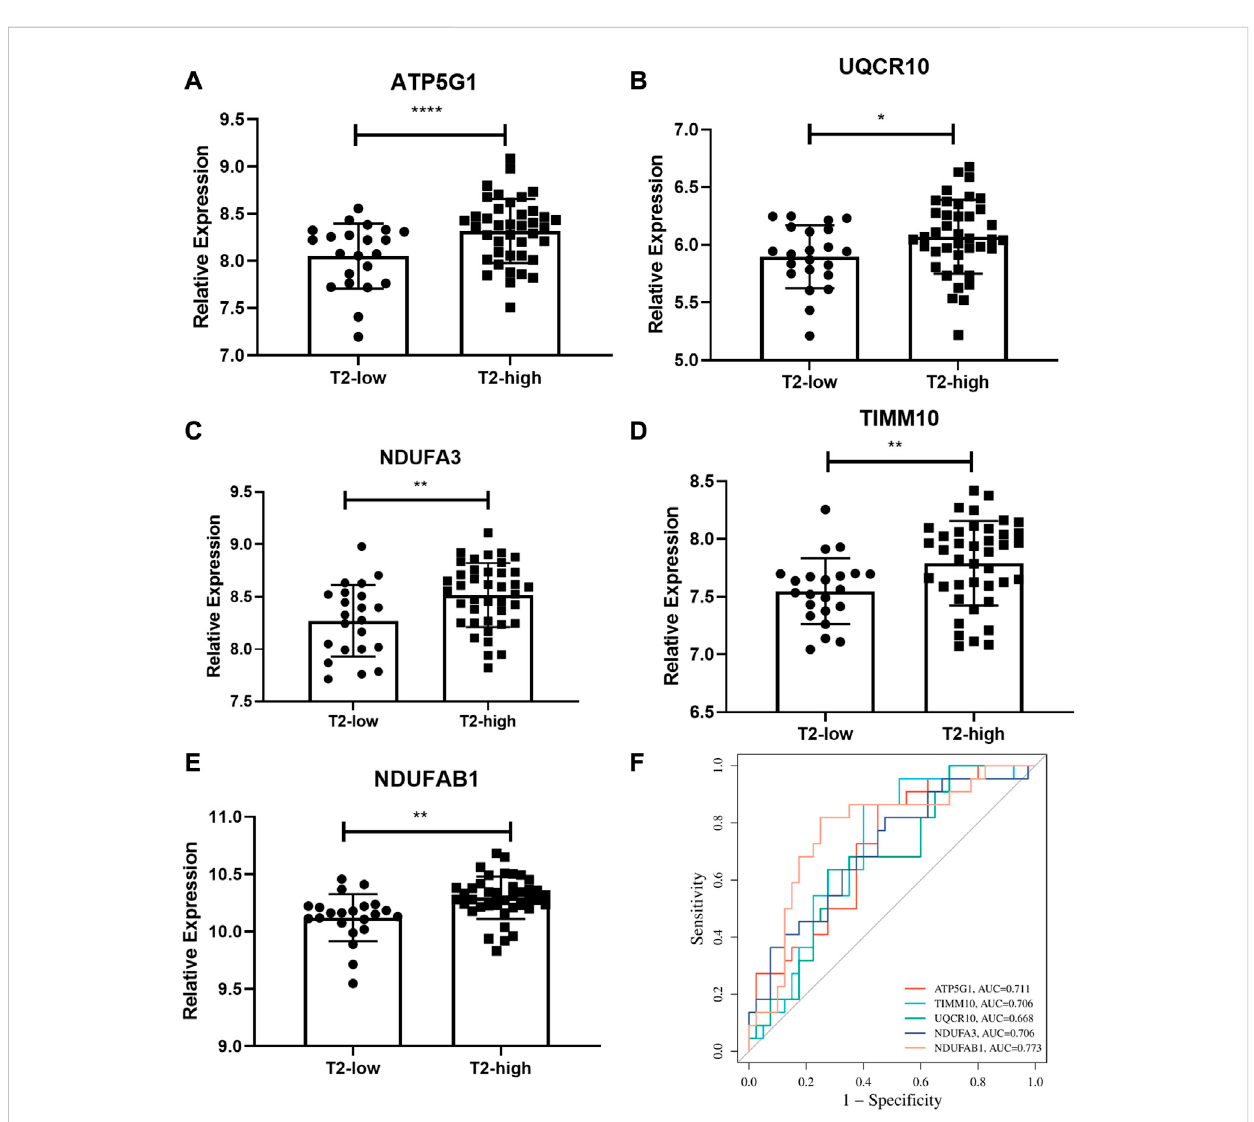
FIGURE 6 Validation of the hub gene levels. (A – E) GSE67472 data set was used to verify the hub gene levels of ATP5G1, UQCR10, NDUFA3, TIMM10, and NDUFAB1 ; (F) ROC curve of hub genes in dataset GSE67472. *p < 0.05, **p < 0.01, ****p < 0.0001.